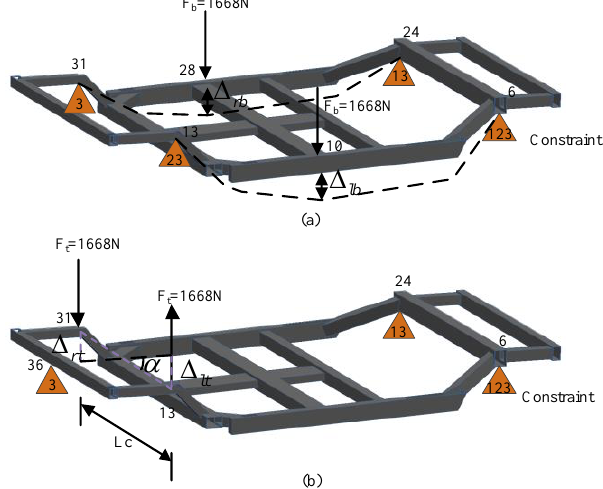
Figure 4. The static load cases and boundary conditions of BIW structure: ( a ) bending condition, ( b ) torsion condition.